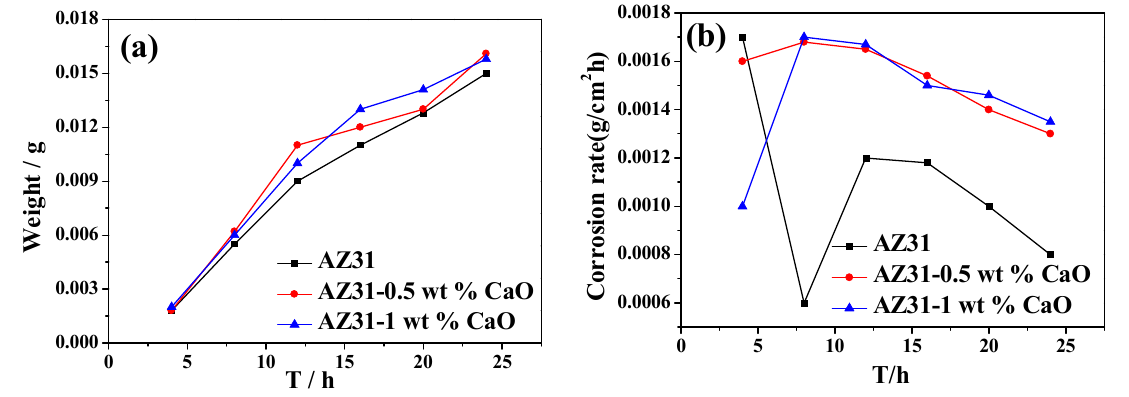
Figure 12. The corrosion weight loss curve ( a ) and corrosion rate curve ( b ) of AZ31-xCaO alloys.